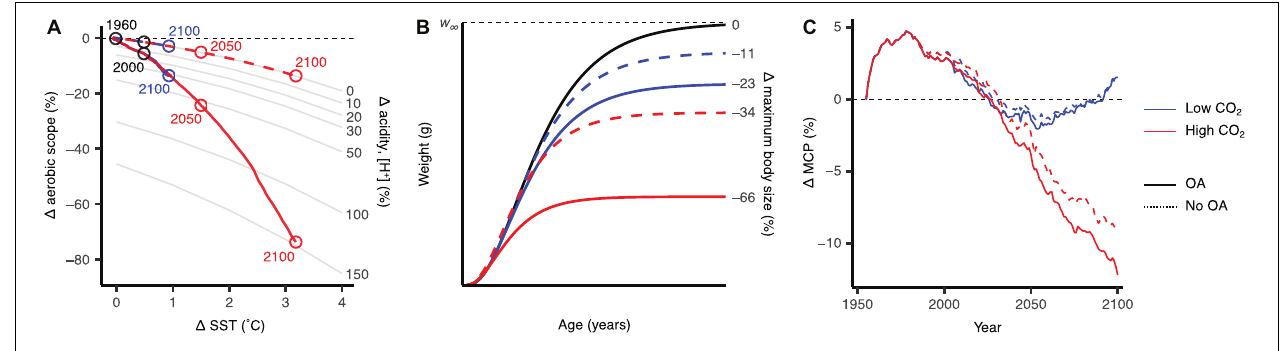
FIGURE 2 | Scaling the multi-stressor responses from the organism level to fisheries catch under the low CO 2 and high CO 2 climate change scenarios (blue and red, respectively), averaged across all modelled species ( N = 210). Differences between projections with and without the modelled effects of ocean acidification (OA) are shown with solid and dashed lines, respectively. (A) Effects of projected ocean warming and acidification on aerobic scope for growth. (B) Change in the von Bertalanffy growth curve and maximum body size in the 2091–2100 period. (C) Changes in global maximum catch potential (MCP) projected by the dynamic bioclimatic envelope model. Results shown are relative to the 1951–1960 period and are multimodel averages from the three earth system models used in this study.